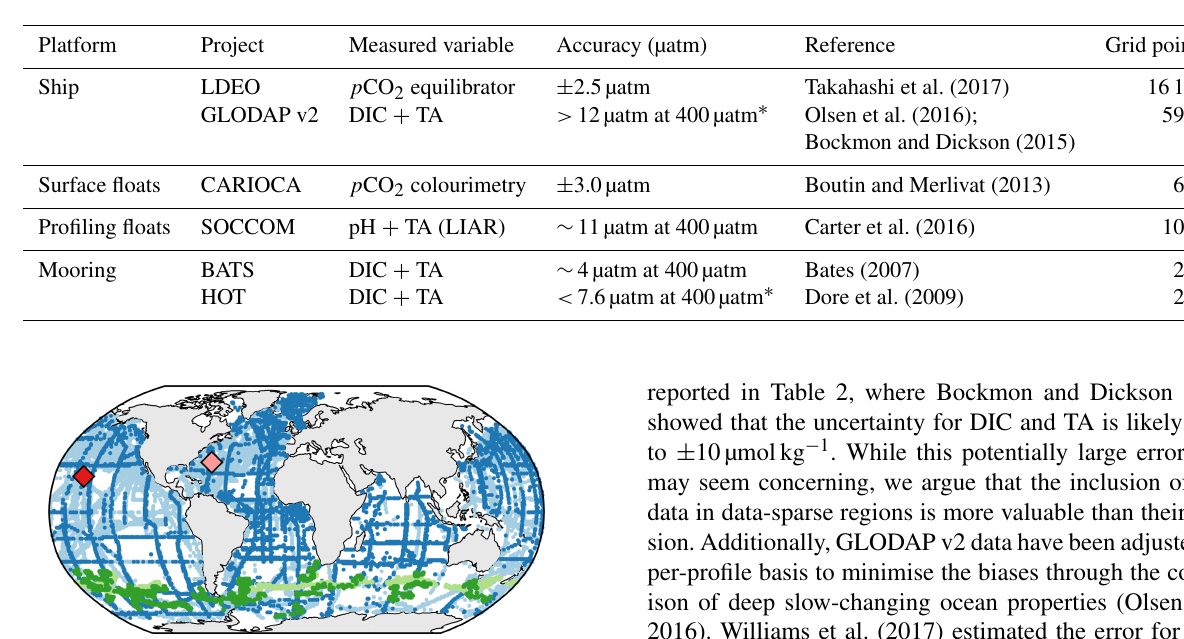
Table 2. Details for the validation datasets. The measured variables are shown (DIC is dissolved inorganic carbon; TA is total alkalinity) along with the estimated accuracy of p CO 2 . This includes the propagated uncertainty in the conversion from DIC and TA to p CO 2 as defined by Lueker et al. (2000), where the estimates marked with ∗ are an extrapolation of the estimates, as the DIC and TA uncertainties do not match or exceed those listed in the publication. Note that the error estimates for GLODAP v2 are larger than those shown in the table, as measurement uncertainty is defined as ± 10µmolkg − 1 in Bockmon and Dickson (2015). Grid points show the number of data at the same resolution as the feature variables.